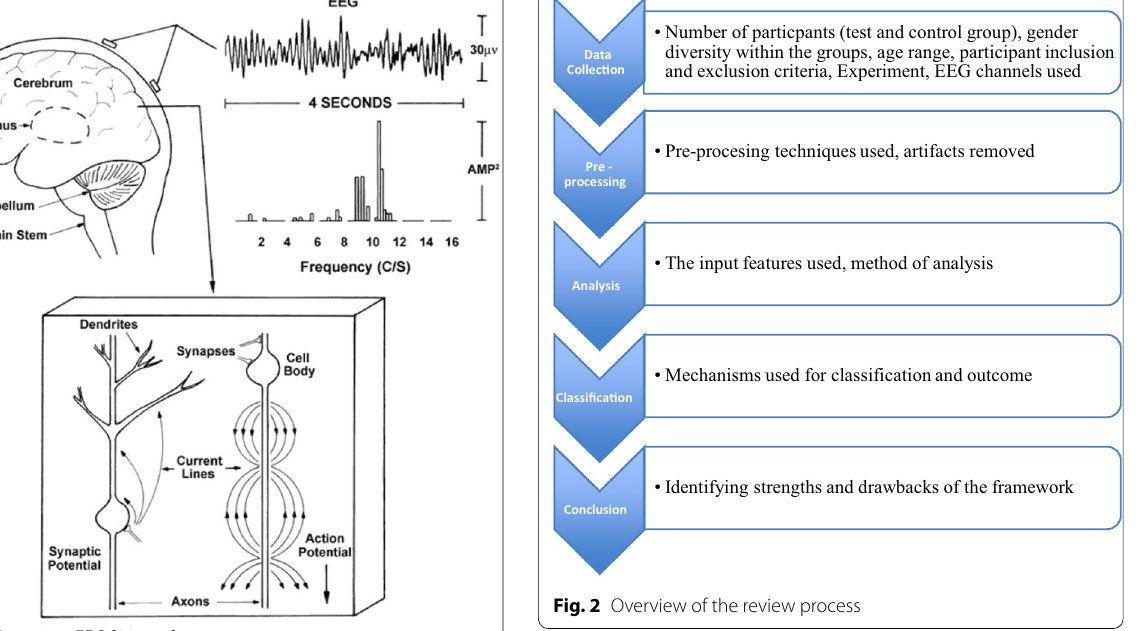
Fig. 1 Capturing EEG [30, p.